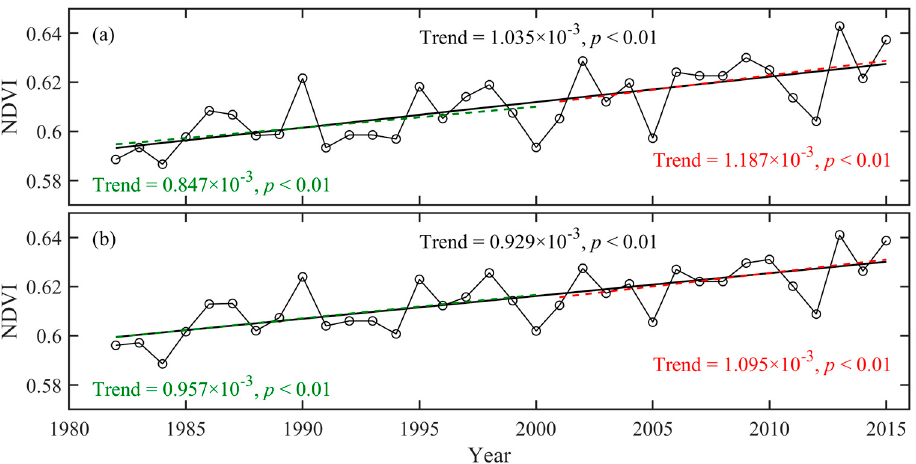
Figure 10. Long-term linear trend of vegetation NDVI in karst area ( a ) and non-karst area ( b ) over Southwest China from 1982 to 2015. The regressions from 1982 to 2015, 1982 to 2000 and 2001 to 2015 are labeled in black, green and red, respectively.